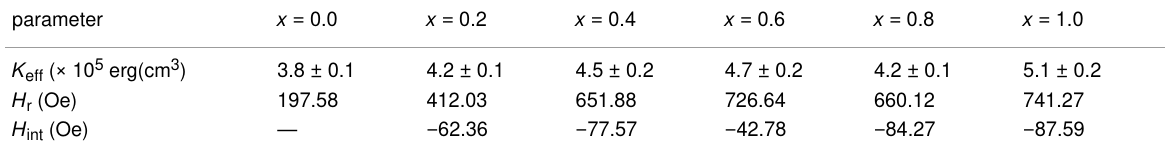
Table 3: Efective anisotropy constant ( K eff ), reverse field ( H r ) and mean interaction field ( H int ) of the Co x Fe 3 − x O 4 samples.